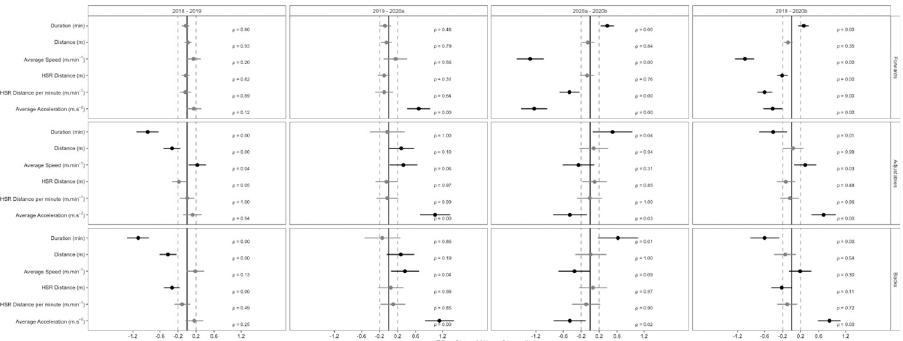
Fig 1. Standardised effect size ( ± 90% confidence interval) differences in whole-match duration and locomotor characteristics between SL seasons 2018 to 2020 b